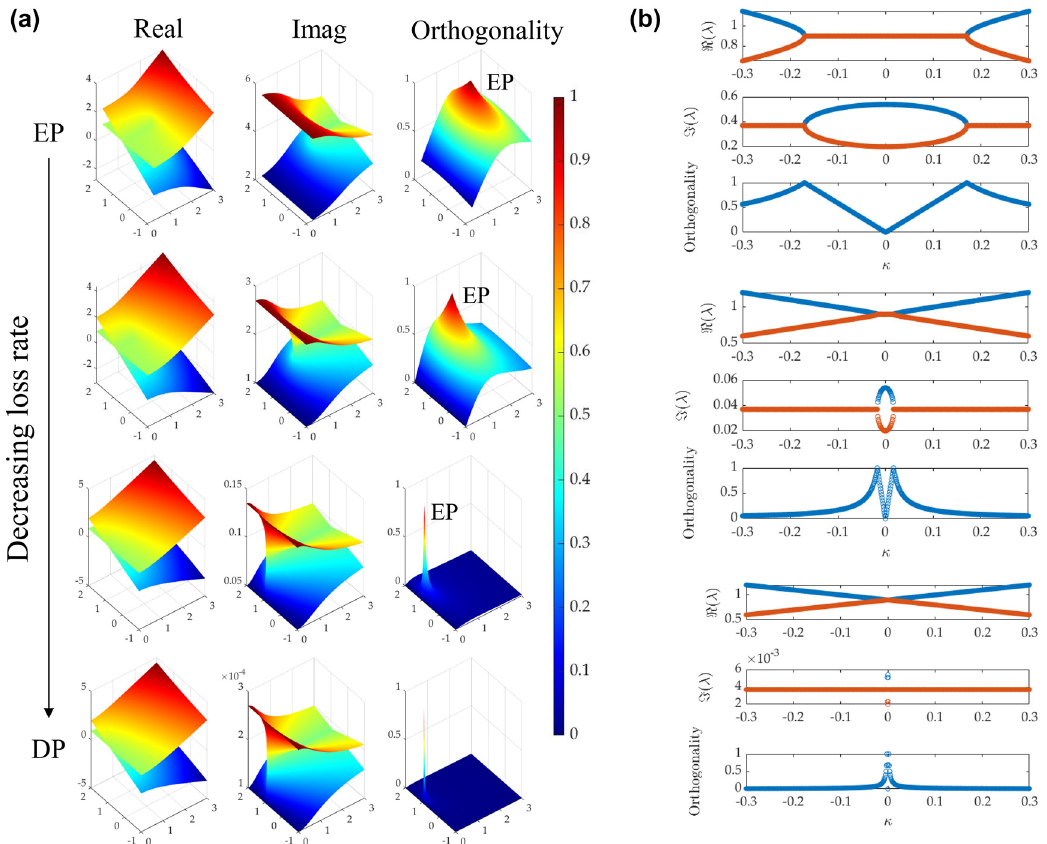
Figure 4: Evolution of EPs and their orthogonality with reducing loss rate. (a) Riemann surfaces of the real (first column) and the imaginary (second column) parts of eigenvalues cross at the EP and the orthogonality around the EP (third column) with a loss rate reduced by a factor of 1, 2, 20, and 500. The surfaces are obtained by sweeping frequency detuning and coupling strength with normalized values. (b) The real and the imaginary parts of the eigenvalues and the orthogonality versus the coupling strength with a loss rate reduced by a factor of 1, 4, and